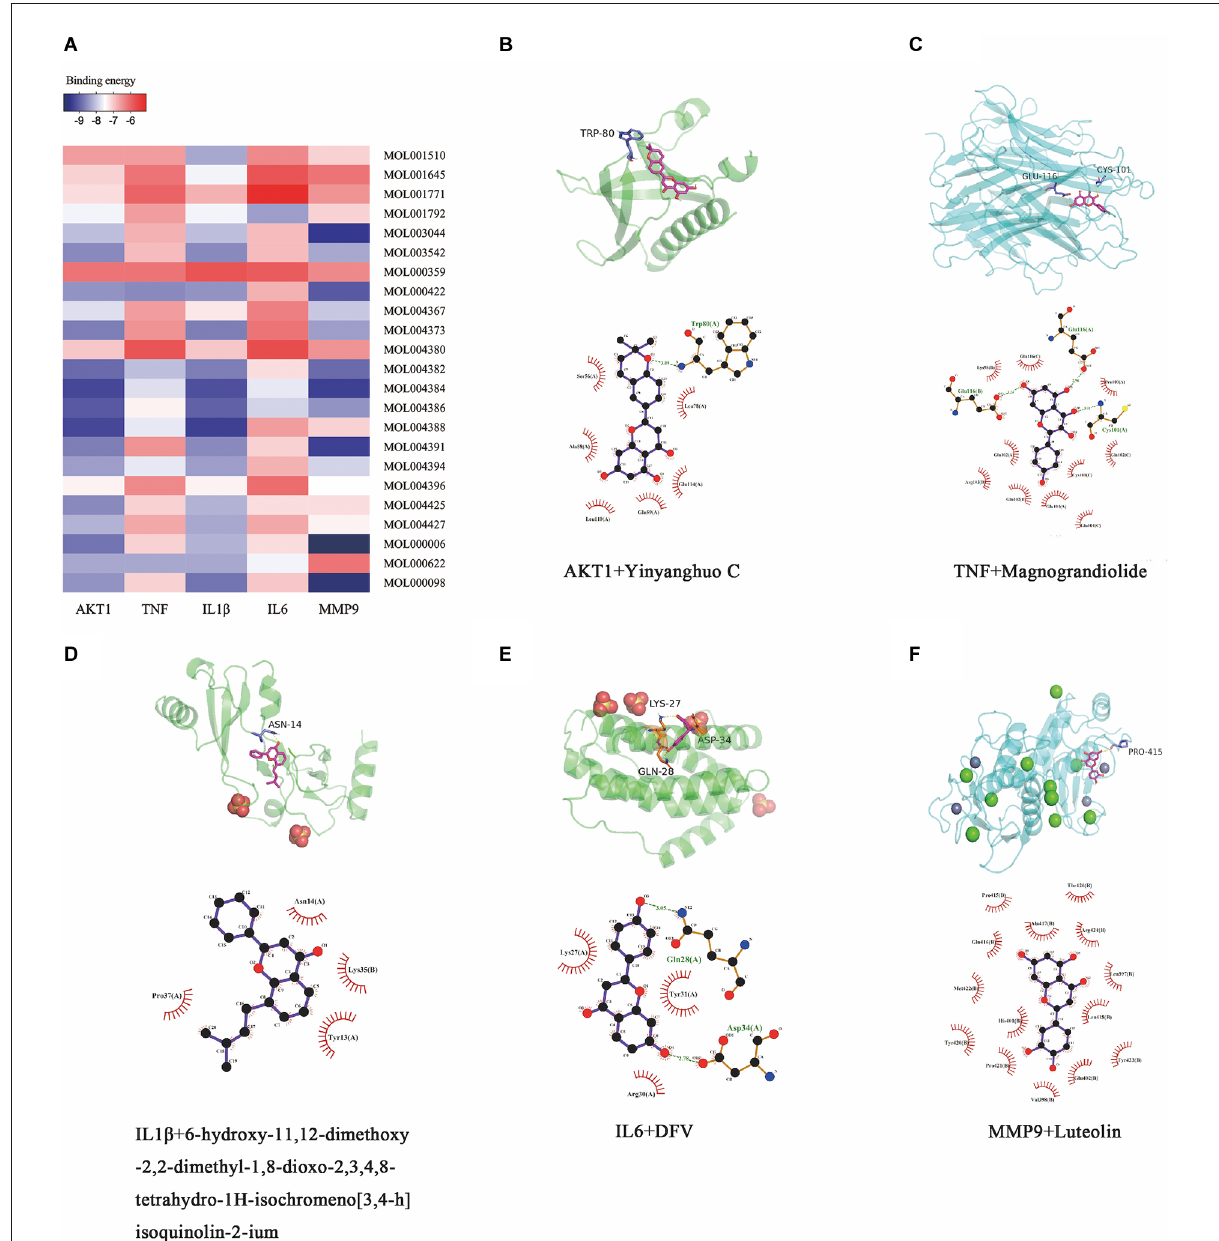
FIGURE9 Molecular docking results. Heatmap and molecular docking results of molecular docking. (A) The binding energy value of molecular docking. (B) AKT1 docked with Yingyanghuo C. (C) TNF docked with Magnograndiolide. (D) IL1 β docked with 6-hydroxy-11,12-dimethoxy-2,2-dimethyl-1,8- dioxo-2,3,4,8-tetrahydro-1H-isochromeno[3,4-h]isoquinolin-2-ium. (E) IL6 docked with DFV. (F) MMP9 docked with